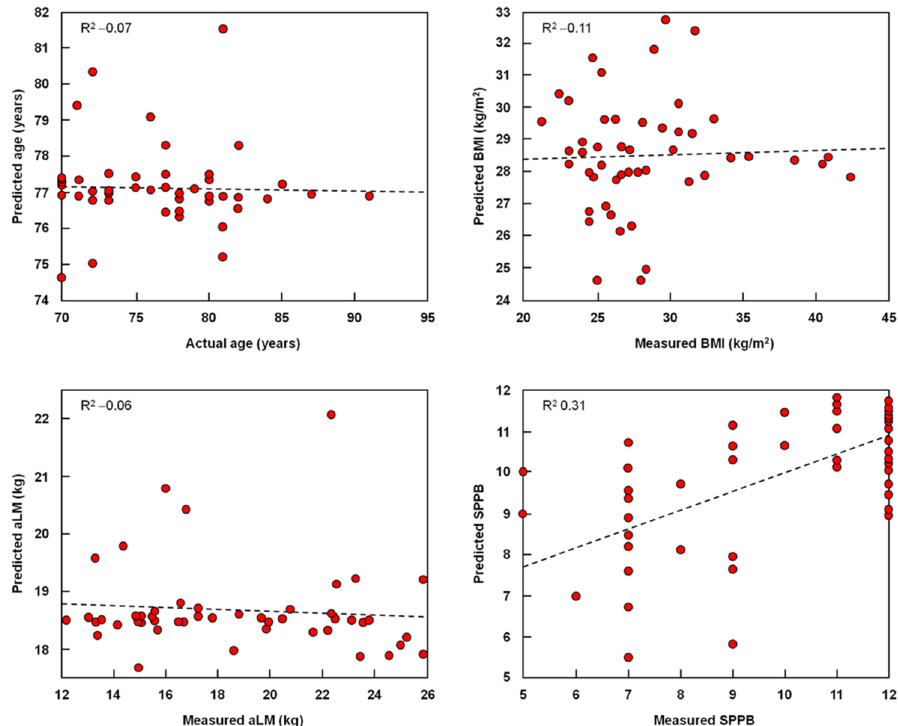
Figure 4. Kernel Partial Least Squares Models to Explore Relationships between Circulating Markers and Age, Anthropometric Measures, and Physical Performance. The models compared the actual values of individual variables and model predictions in the outer double cross-validation loop. Abbreviations: aLM, appendicular lean mass; BMI, body mass index; SPPB, short physical performance battery.